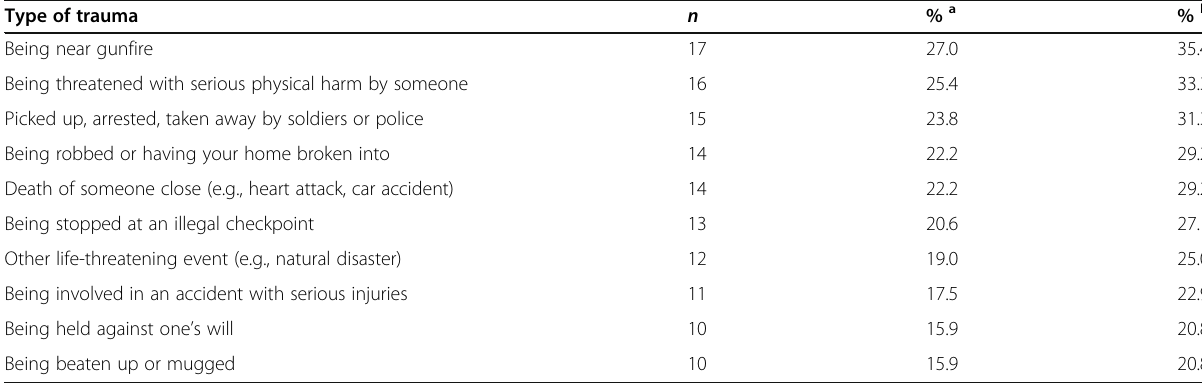
Table 4 provides the hierarchal regression used to fur-